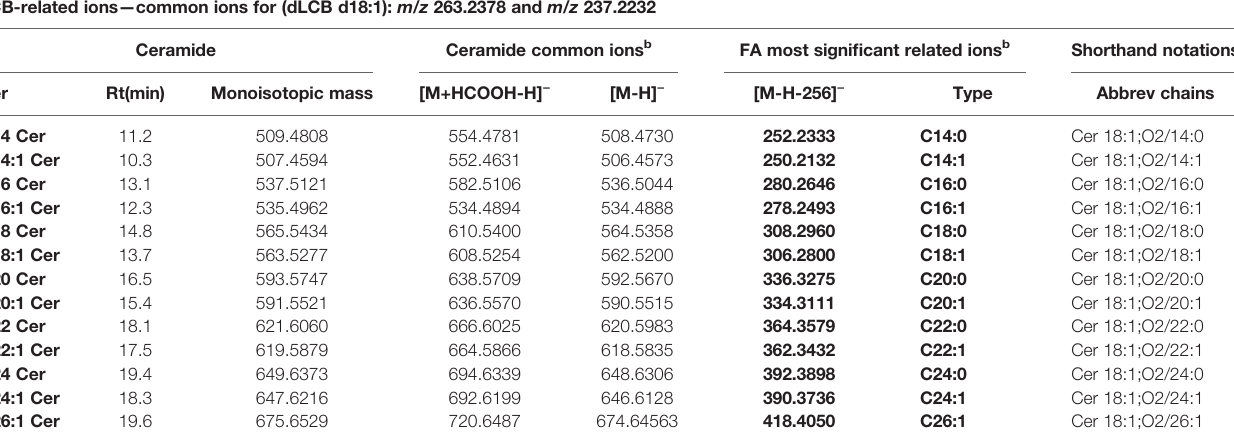
TABLE 2 | Characterization of ceramides present in cells and exosomes from GCS phenotypes using UHPLC/ESI( − )-Q-TOF-MS/MS a . LCB-related ions — common ions for (dLCB d18:1): m / z 263.2378 and m / z